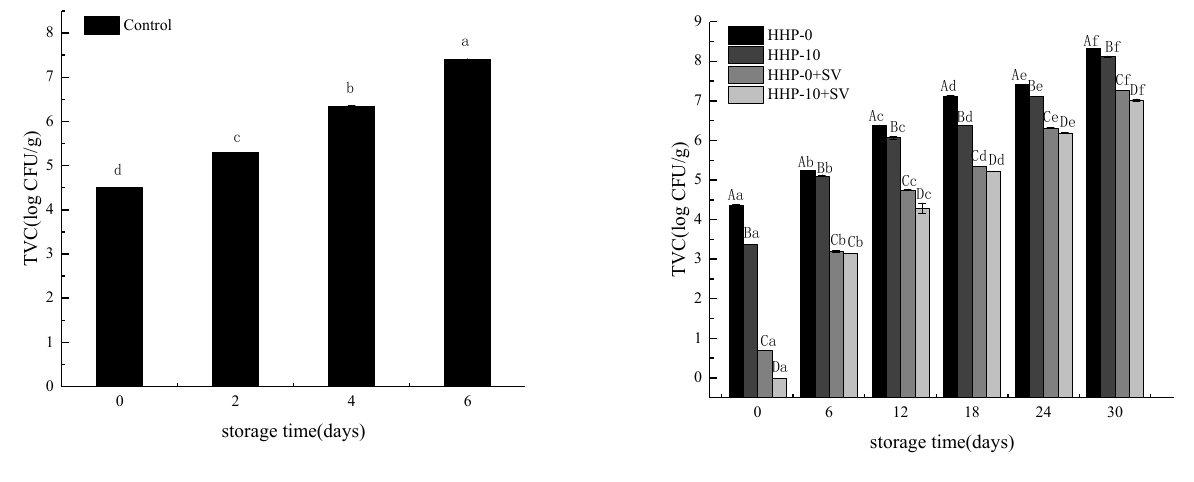
Figure 1. The effect of different treatments on the number of TVC of largemouth bass during storage. A–D: Differences between different treatment groups; a–f: Differences in treatment groups during storage.